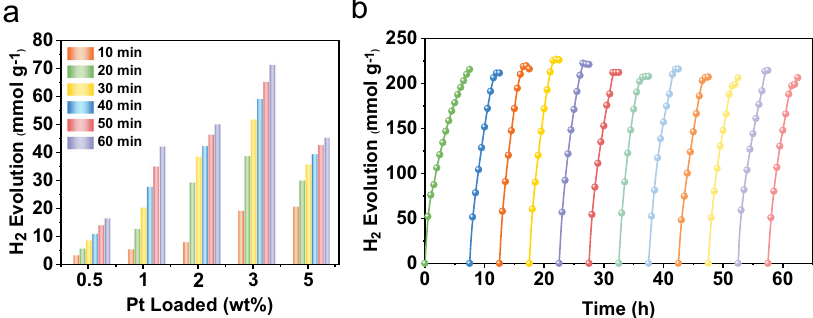
Fig. 4 Hydrogen production performances. a Time dependent hydrogen evolution for PY-DHBD-COF with different Pt loading amount. (10 mg catalyst was dispersed in 100 mL water, 10 mM ascorbic acid as electron donor, H 2 PtCl 6 (0.376 g Pt L − 1 ) as Pt precursor, 300 W Xe lamp, λ > 420 nm). b Long- term hydrogen production for 3 wt% Pt loaded PY-DHBD-COF (Detailed data are listed in Supplementary Table